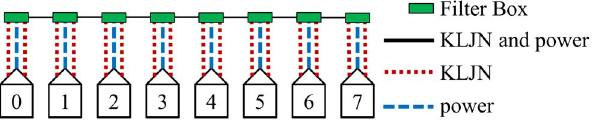
Figure 4. Example for network of size N= 7. Each host is connected to a filter box and the filters boxes are connected to the power grid. Note how each host has three wire connections to its filter